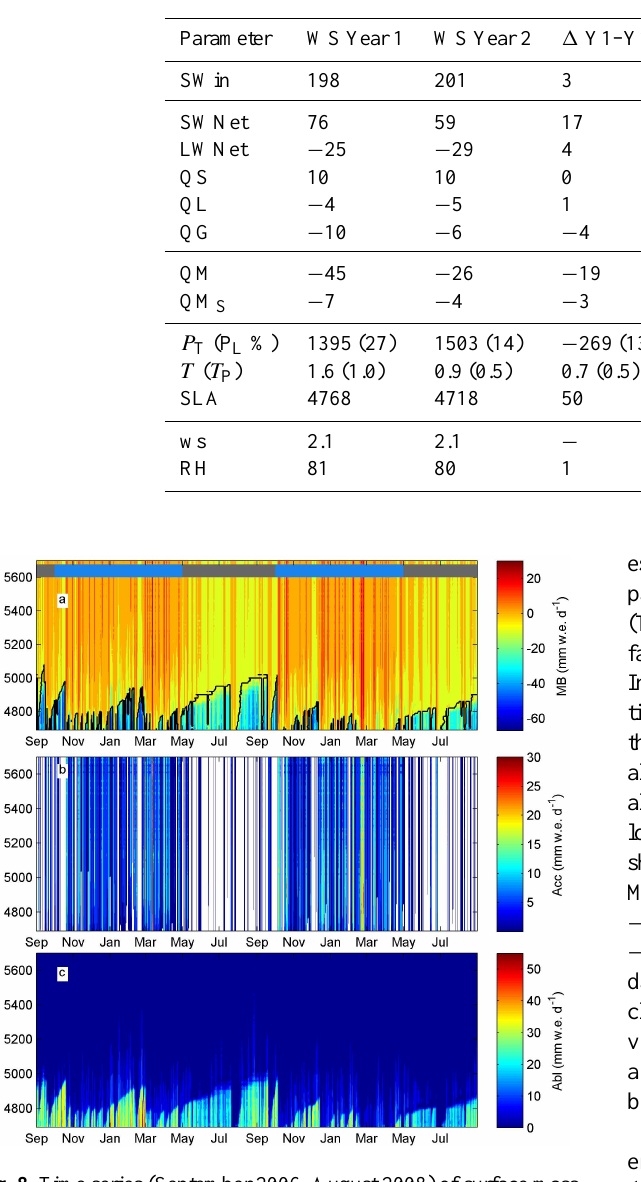
Fig. 8. Time series (September 2006–August 2008) of surface mass balance (a) with the dry and wet season duration highlighted by the grey and blue bars and mean snow line (snow depth ≥ 1cm) in- dicated as black line. Time series of snow accumulation and total ablation in (b) and (c) . White areas in (b) correspond to no accu- mulation. All values are calculated as daily means for 10m steps in altitude. Note the different scales of the color